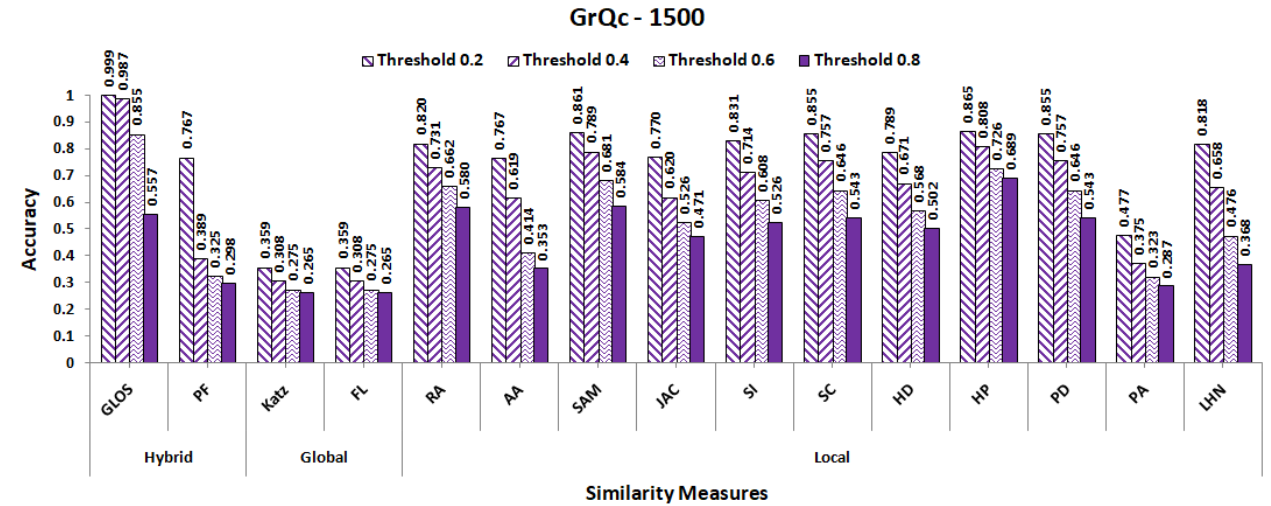
Figure 14. Comparisons of similarity measures on GrQc-1500 edge list from GrQc dataset